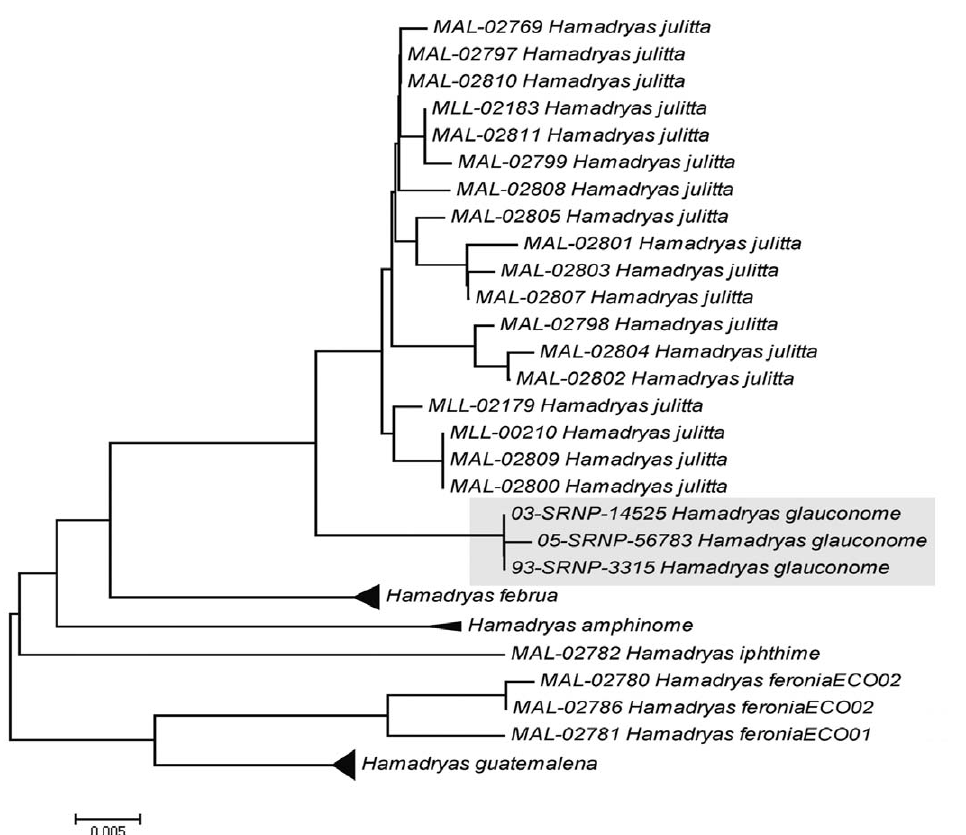
Figure 5. Neighbor-joining tree for the genus Hamadryas . H. julitta, an endemic from the Yucatan Peninsula, is most closely related to H. glauconome from Costa Rica (in grey). Barcoding also revealed H. iphthime , a species overlooked in the collection because of its close similarity to Hamadryas feronia , and two clusters of H. feronia.